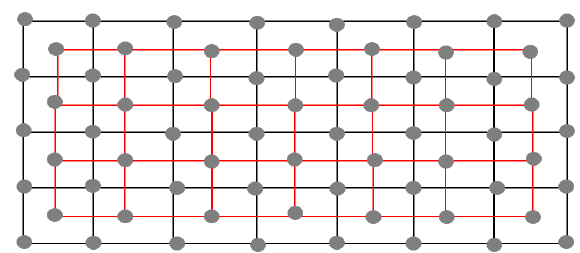
Figure 2. Receptor locations defined on corners (gray points) of two 20x20 meter grids (black and red grids)